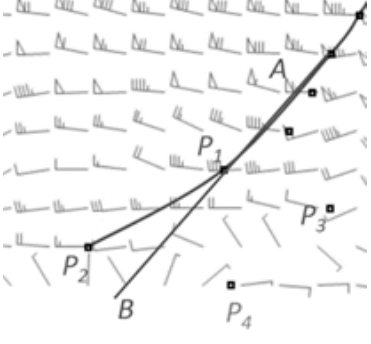
Figure 2. Selection of the next trough point.